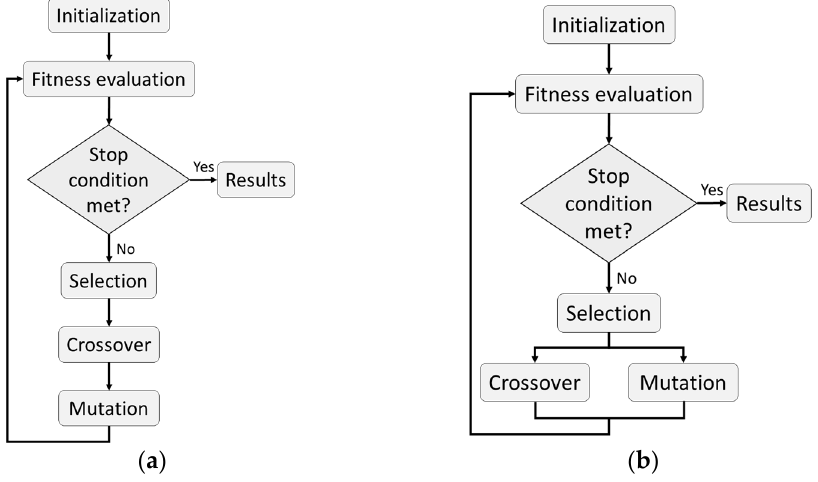
Figure 3. Genetic algorithm procedure: ( a ) typical vs. ( b ) proposed.